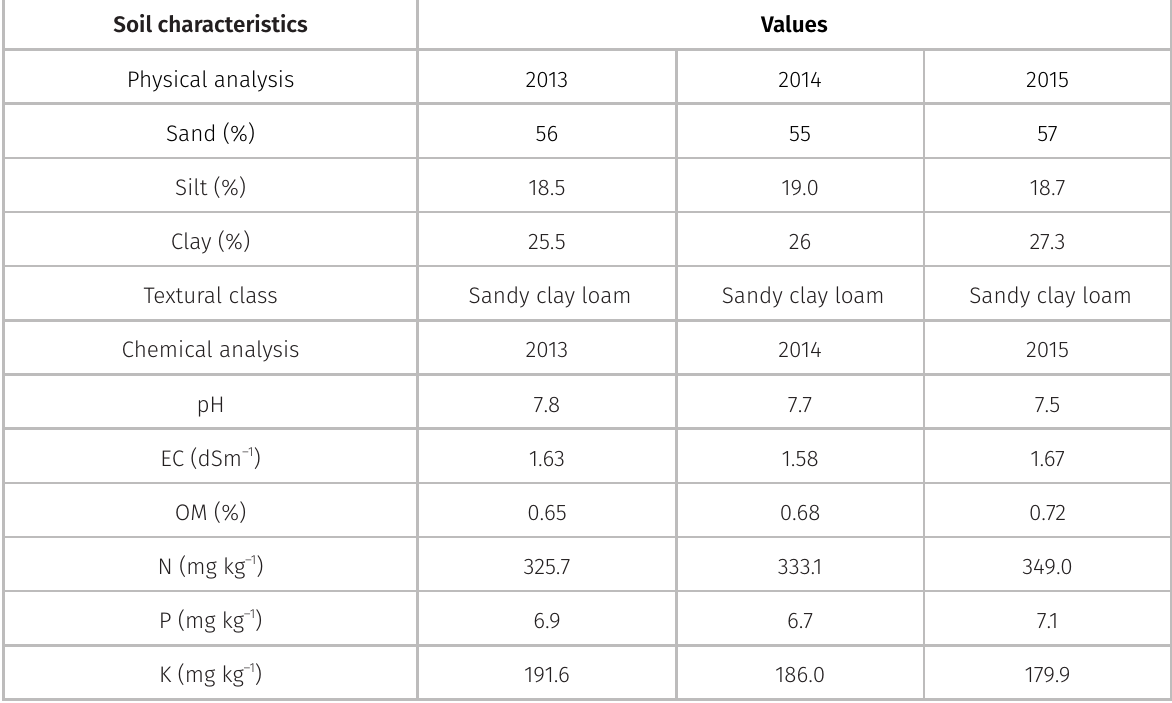
Table I. Experimental soil’s analyses before the sowing of forage soybean for physical and chemical properties at Faisalabad,